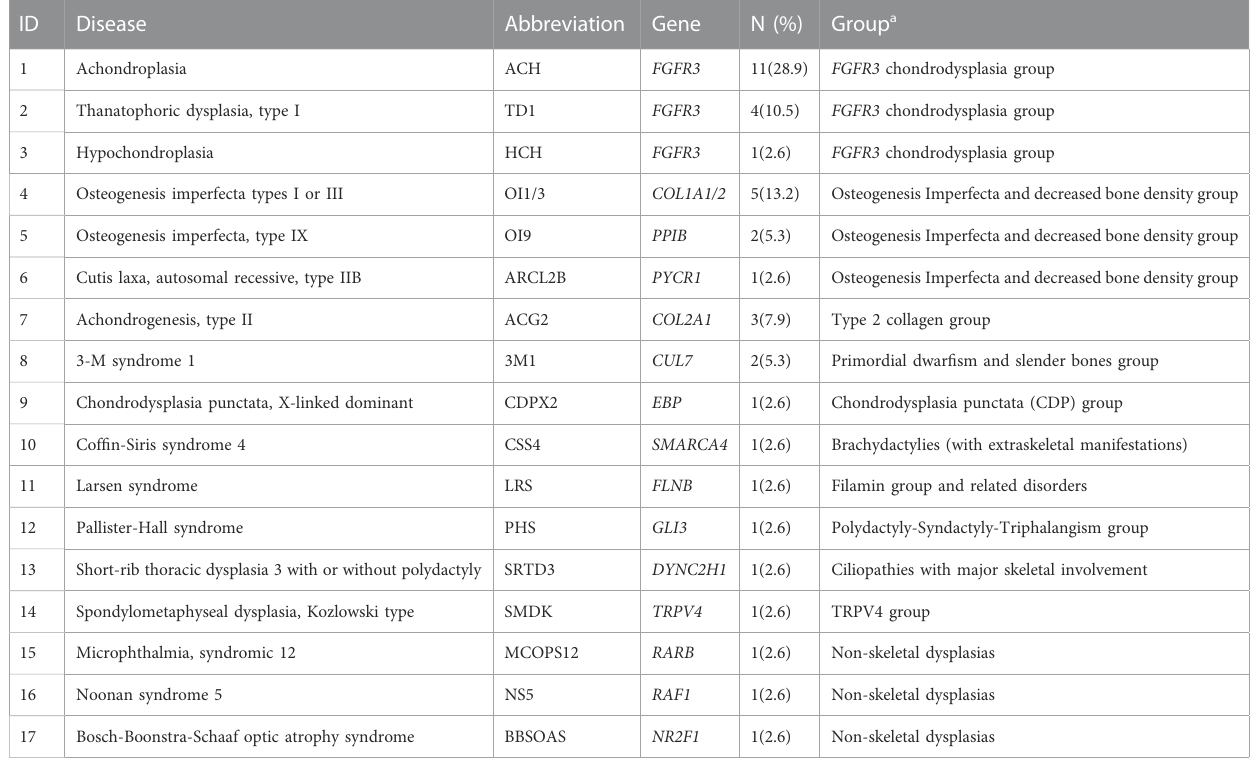
TABLE 3 Etiologic diagnosis and categories for 38 fetuses with genetic disorders.